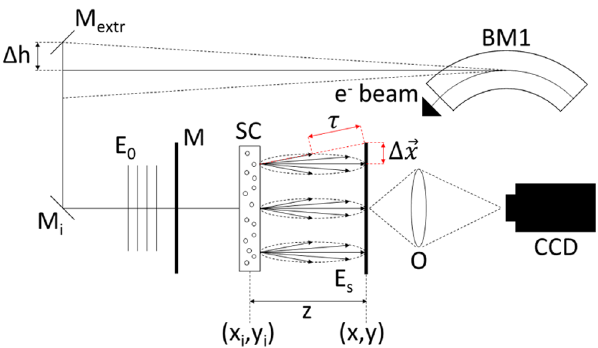
FIG. 9. HNFS experimental setup at ALBA: SR is emitted at Bending Magnet 1 (BM1) and visible light is selected by an extraction mirror M that can be inserted from 25 mm to 7 mm extr from the orbit plane ( Δ h ). A system of flat mirrors M i delivers the radiation (E 0 ) to the scattering cell SC and the interference with the scattered field E s is imaged by the microscope objective O onto the CCD. A micrometric translation stage allows to scan the distance z from the particle plane ð x i ; y i Þ to the image plane (x,y). Whether the monochromator M is used defines narrow-band or broad-band conditions, respectively. The dashed red lines allow to relate the parameter Δ x of the radiation CCF and the parameter τ of the radiation CDC to the geometry of the HNFS setup, as also previously explained in Sec. II A and Sec. II B, respectively.